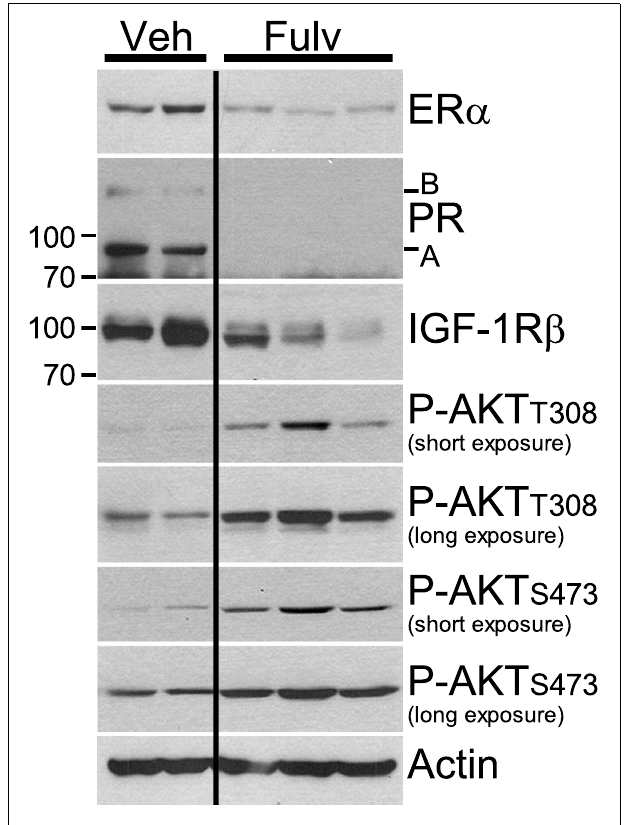
FIGURE 2 | Estrogen receptor inhibition with fulvestrant induces upregulation of PI3K signaling. Ovariectomized athymic mice were s.c. implanted with MCF-7 cells and a 10-day-release E2 pellet (0.12 mg).Twelve days later, mice were randomized to treatment with vehicle or fulvestrant (5 mg/week, s.c., clinical formulation).Tumors were harvested after 3–4 weeks of treatment.Tumor lysates were analyzed by immunoblotting using the indicated antibodies; each lane contains equal amount of protein from two to three tumors. Fulvestrant treatment decreased the levels of ER and ER-regulated genes products (PR, IGF-1R), but increased levels of P-AKT-T308 and P-AKT-S473, suggesting increased activation of PI3K. All lanes were from the same membrane.